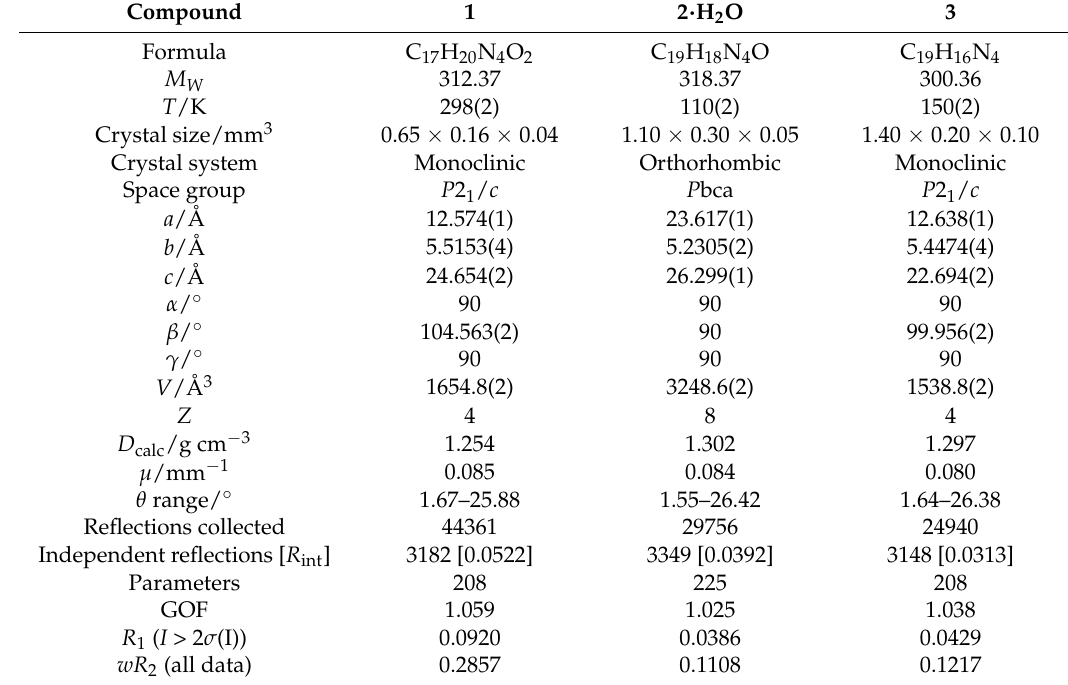
Table 2. Summary of crystallographic data for compounds 1 – 3